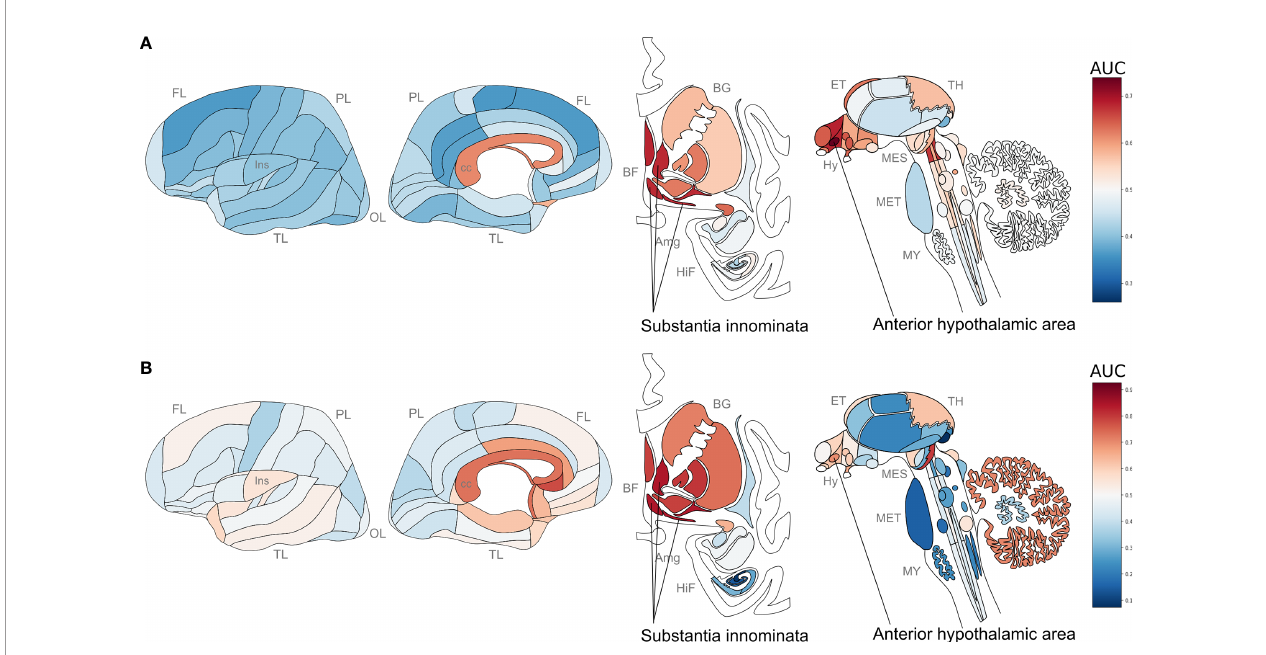
FIGURE 4 | Neuroanatomical heatmaps marking speci fi c expression of the genes up-regulated in samples with P. gingivalis reads (A) and ER translocation genes (B) . AUC values range from depleted expression in dark blue to enriched in dark red. Brain region abbreviations: FL, frontal lobe; PL, parietal lobe; TL, temporal lobe; OL, occipital lobe; BF, basal forebrain; BG, basal ganglia; AmG, amygdala; HiF, hippocampal formation; EP, epithalamus; TH, thalamus; Hy, hypothalamus; MES, mesencephalon; MET, metencephalon; and MY, myelencephalon. Anatomical template images are from the Allen Human Brain Reference Atlas